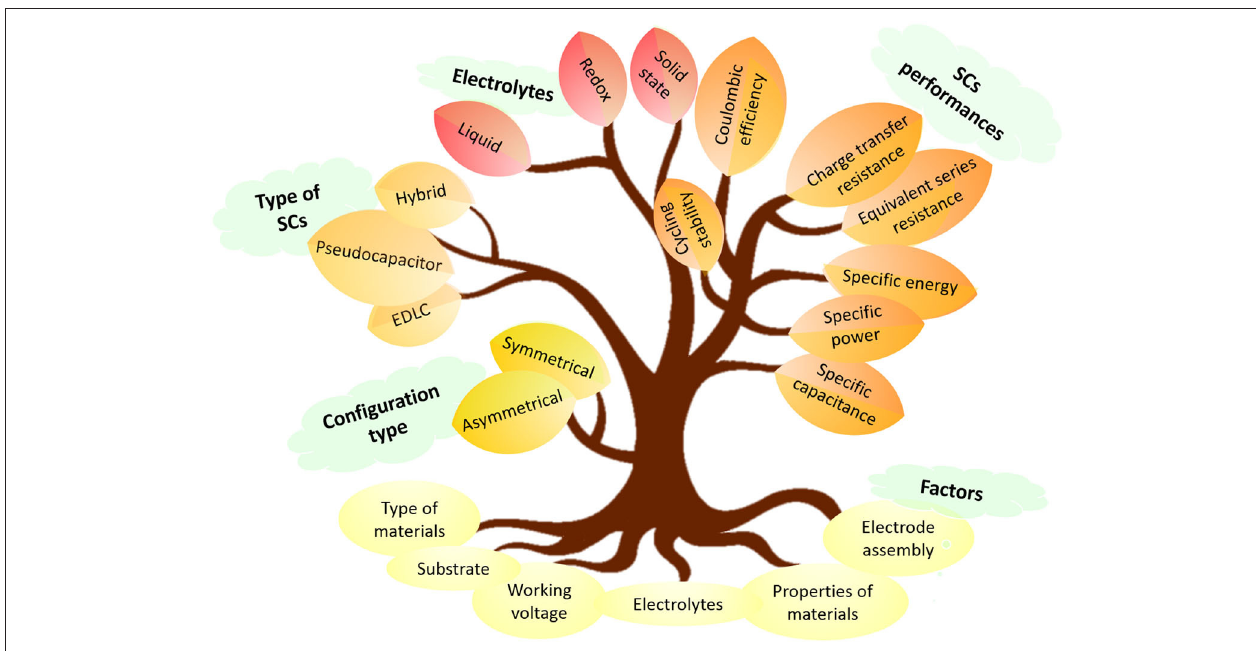
FIGURE 2 | Configuration, types, performance, and factor affecting electrochemical performance of